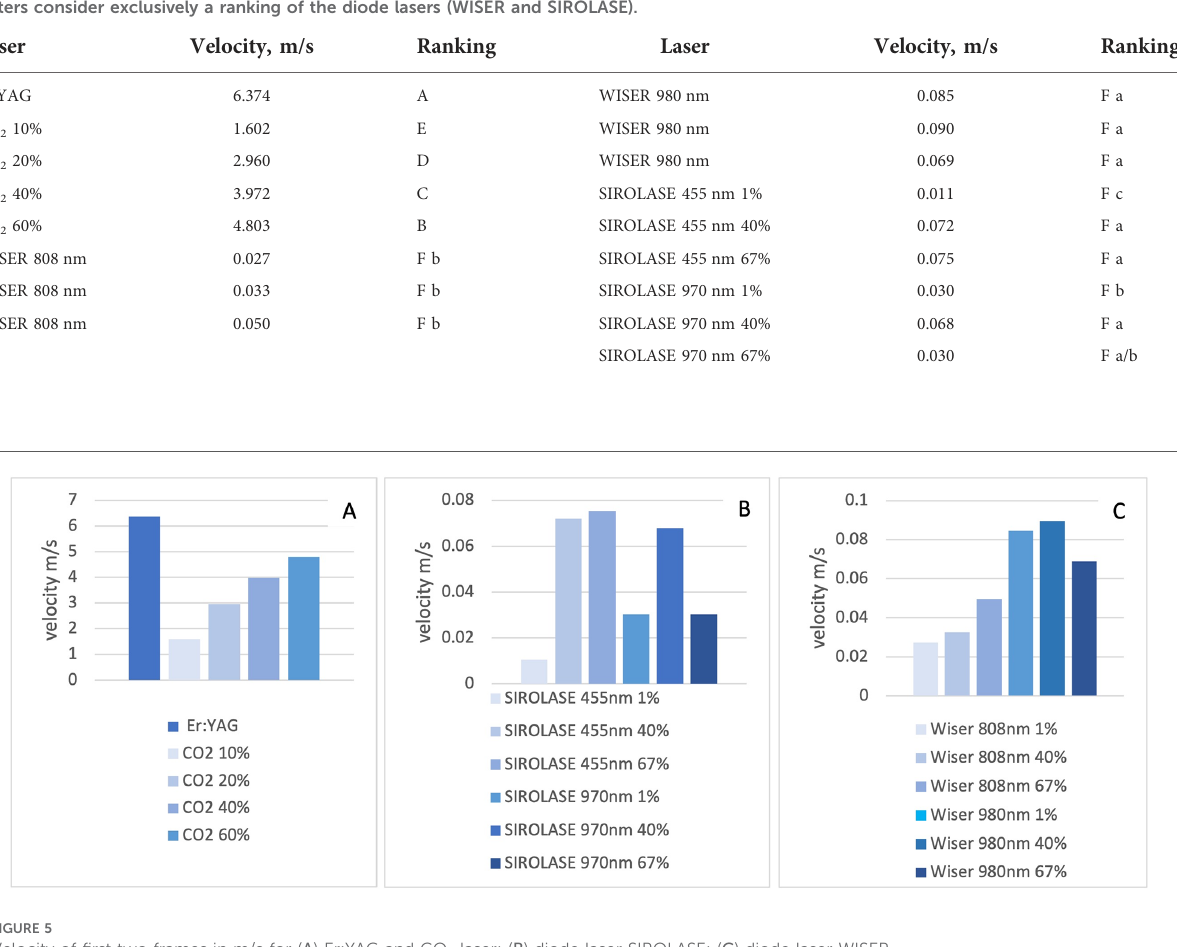
FIGURE 5 Velocity of fi rst two frames in m/s for ( A ) Er:YAG and CO 2 laser; ( B ) diode laser SIROLASE; ( C ) diode laser